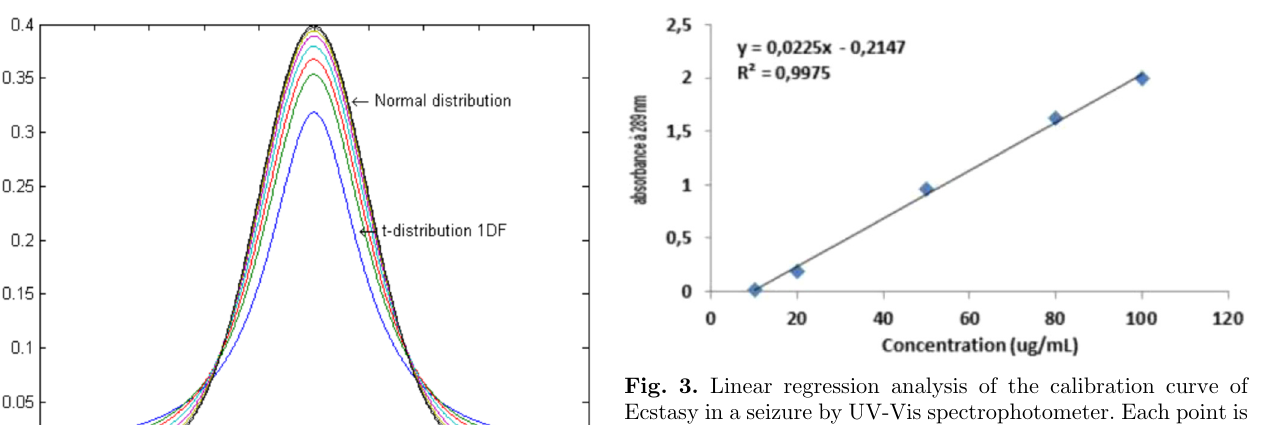
Fig. 1. Student's